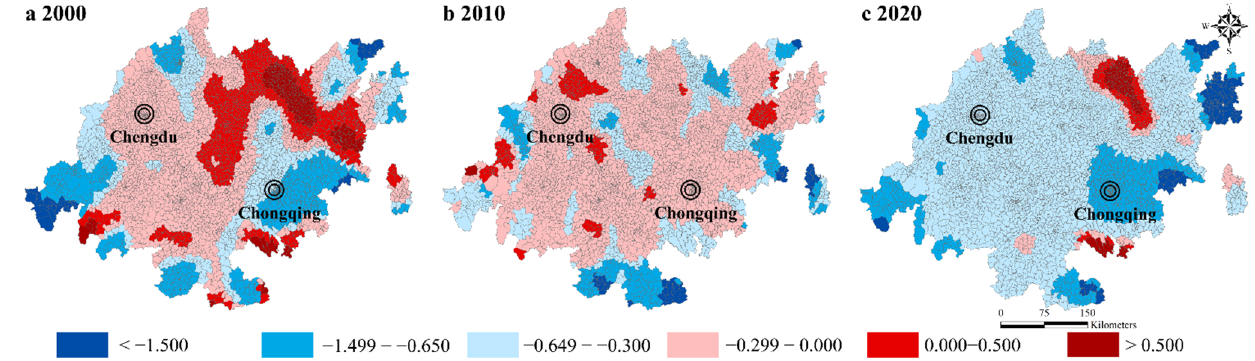
Figure 6. Spatial distribution pattern of regression coefficient of UL.